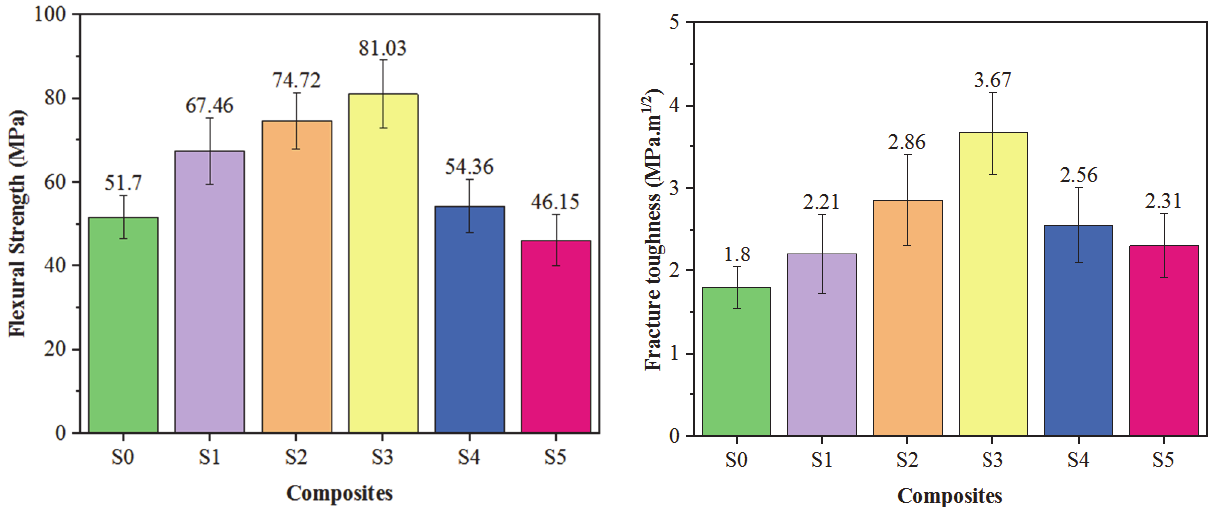
Figure 6: Flexural strength of all composites Figure 7: Fracture toughness of all